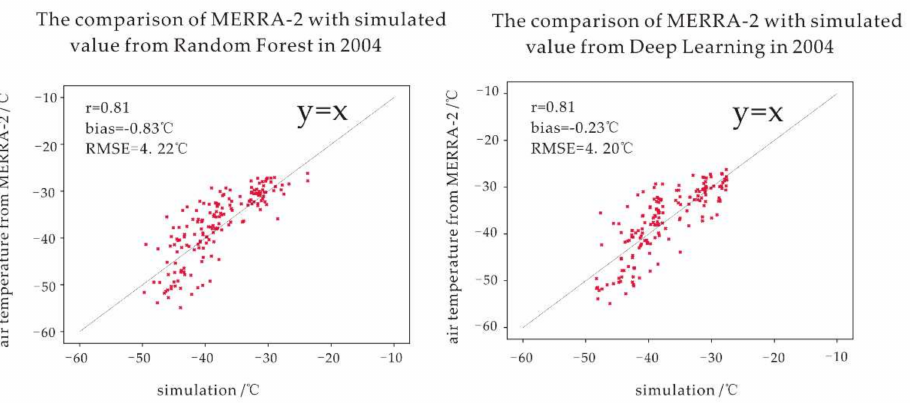
Figure 11. The comparison of the simulated values with MERRA-2.